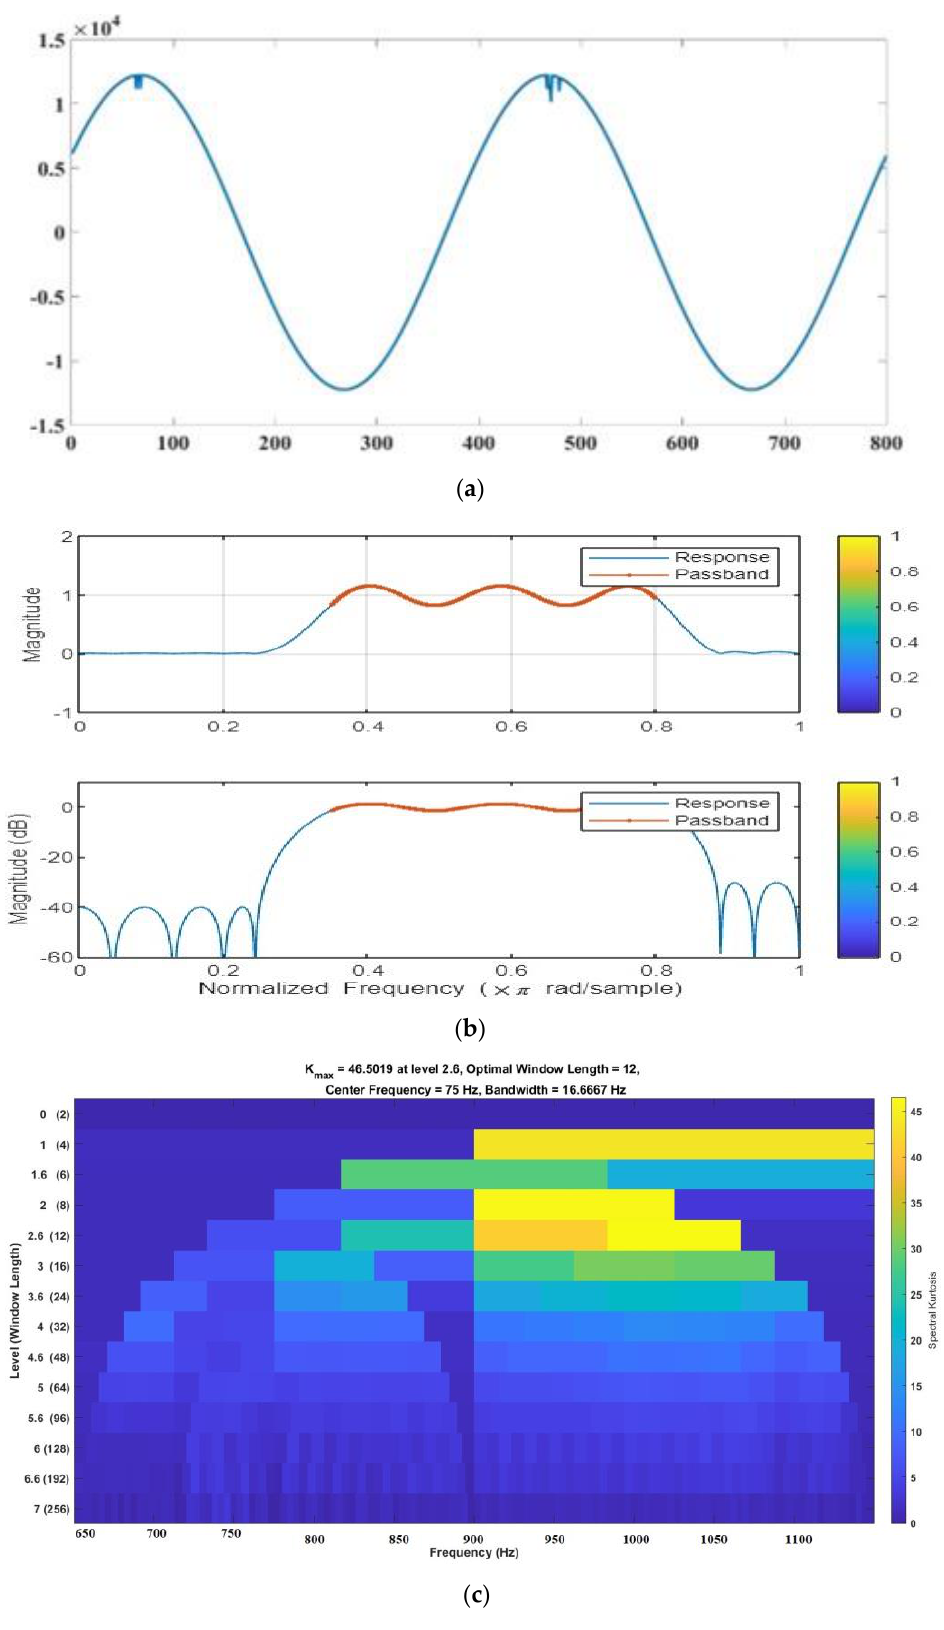
Figure 6. ( a ) Simulated voltage signal for HIF ( b ) Selection of frequency band ( c ) Kourtogram for HIF.